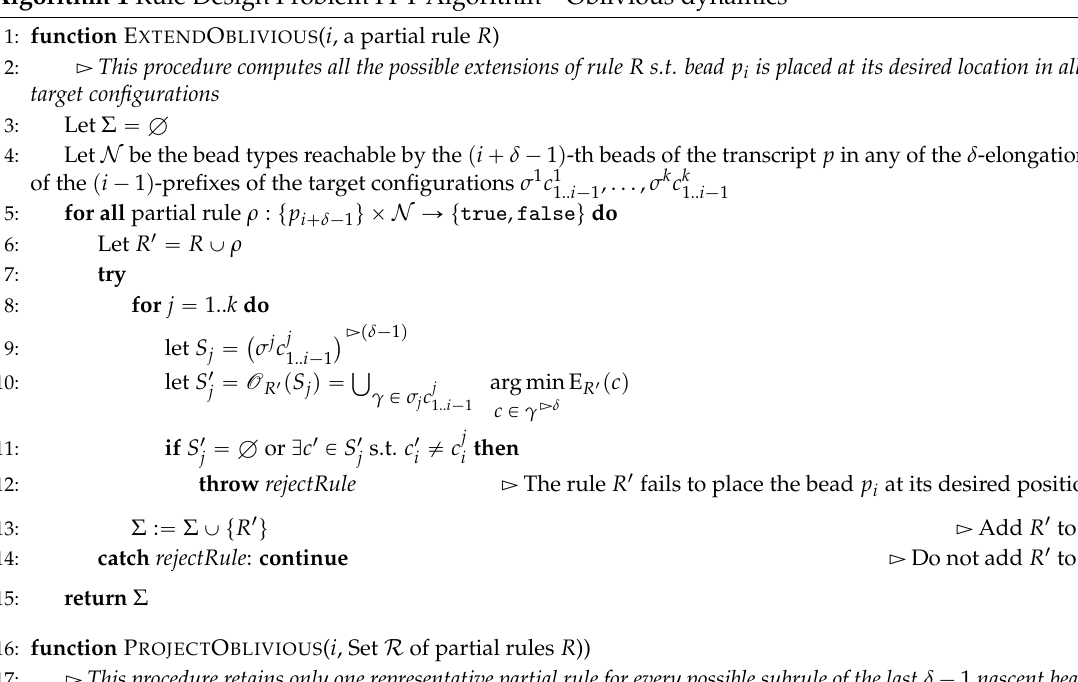
Algorithm 1 Rule Design Problem FPT Algorithm—Oblivious